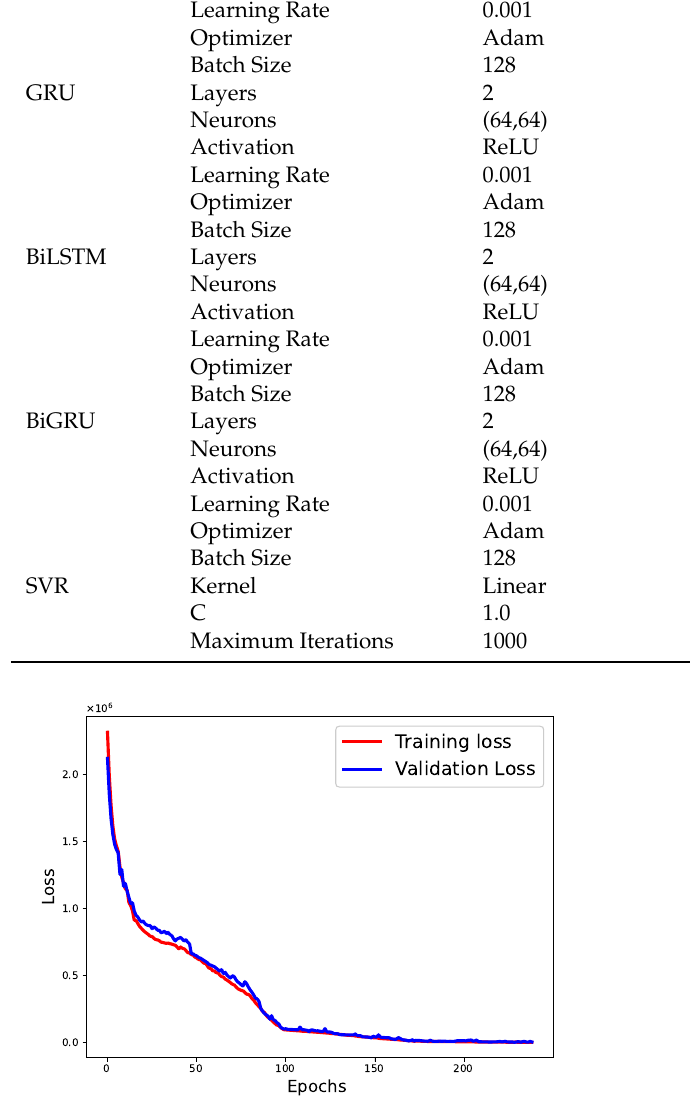
Figure 7. The loss curves of the BiGRU (training and validation